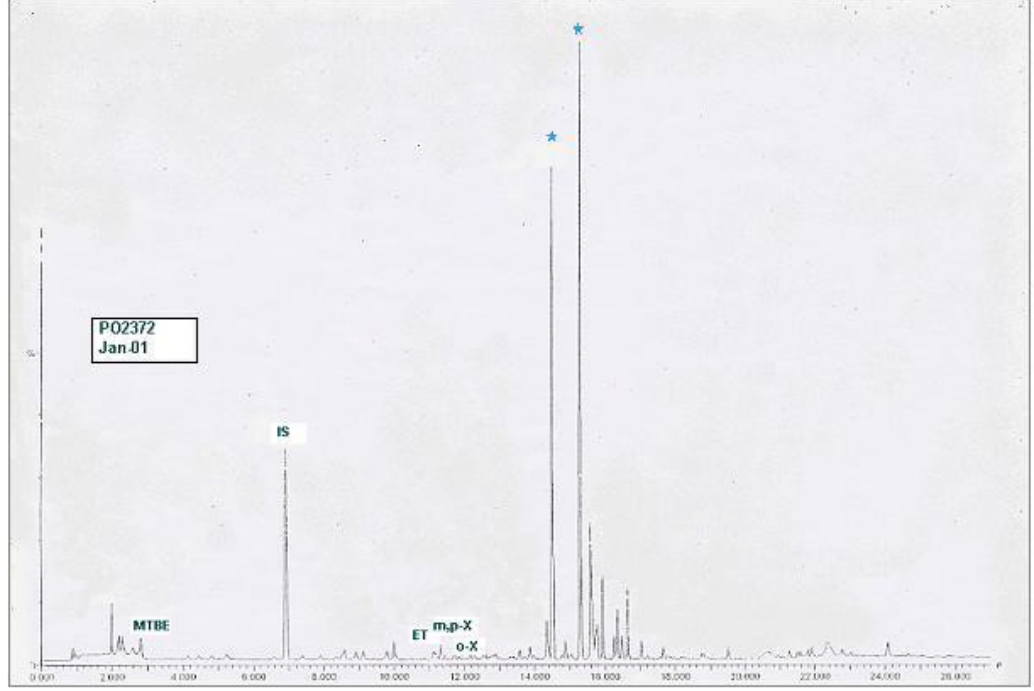
FIGURE 3. Chromatogram of well PO2372 taken in January 2001. Peaks assigned to DCPDs compounds are star marked. (IS = Internal